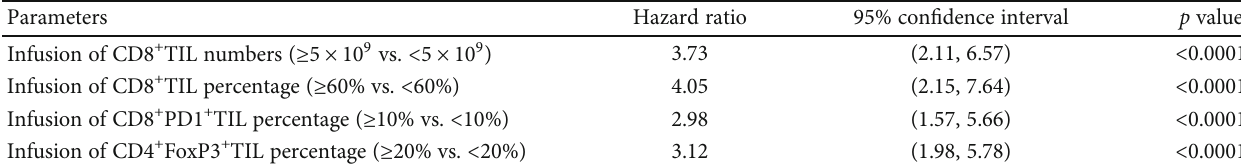
Figure 6: Univariate analyses of more infusion of TIL numbers and CD8 + TIL percentage and less infusion of CD8 + PD1 + TIL percentage and CD4 + FoxP3 + TIL percentage based on PFS and OS. (a) The PFS curve of patients, A: patients with more TIL numbers ( ≥ 5 × 10 9 , blue line) and less TIL numbers ( <5 × 10 9 , red line); B: patients with more CD8 + TIL ( ≥ 60%, blue line) and less CD8 + TIL ( < 60%, red line); C: patients with more CD8 + PD1 + TIL ( ≥ 10%, blue line) and less CD8 + PD1 + TIL ( < 10%, red line); D: patients with more CD4 + FoxP3 + TIL ( ≥ 20%, blue line) and less CD4 + FoxP3 + TIL ( < 20%, red line). (b) The OS curve of patients, A: patients with more TIL numbers ( ≥ 5 × 10 9 , blue line) and less TIL numbers ( <5 × 10 9 , red line); B: patients with more CD8 + TIL ( ≥ 60%, blue line) and less CD8 + TIL ( < 60%, red line); C: patients with more CD8 + PD1 + TIL ( ≥ 10%, blue line) and less CD8 + PD1 + TIL ( < 10%, red line); D: patients with more CD4 + FoxP3 + TIL ( ≥ 20%, blue line) and less CD4 + FoxP3 + TIL ( < 20%, red line). Table 5: Multivariate analysis (mPFS).